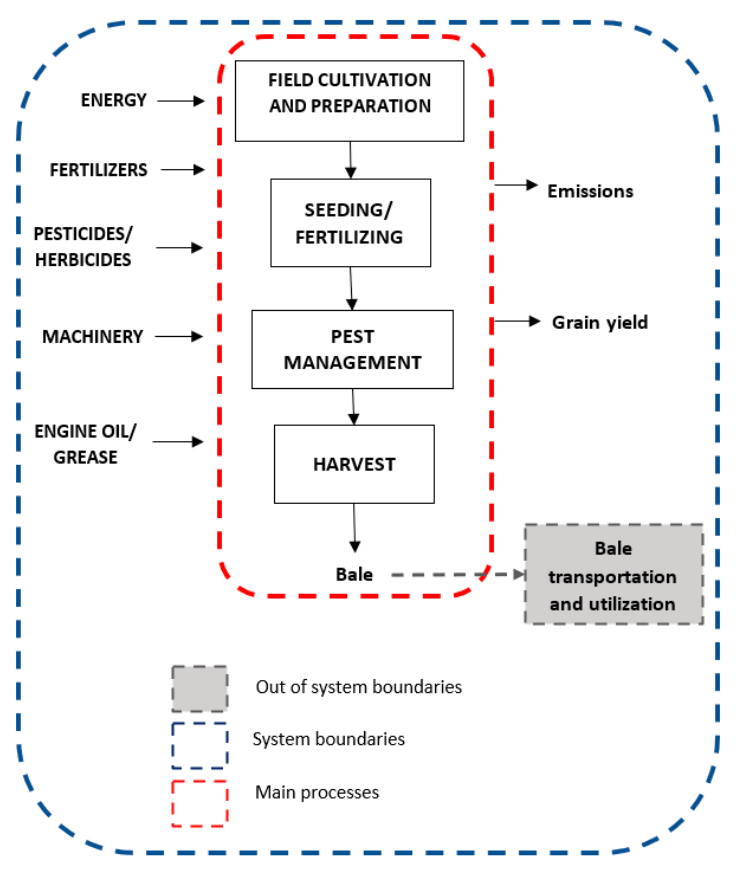
Figure 4. Analytical system modeling of barley production system under study